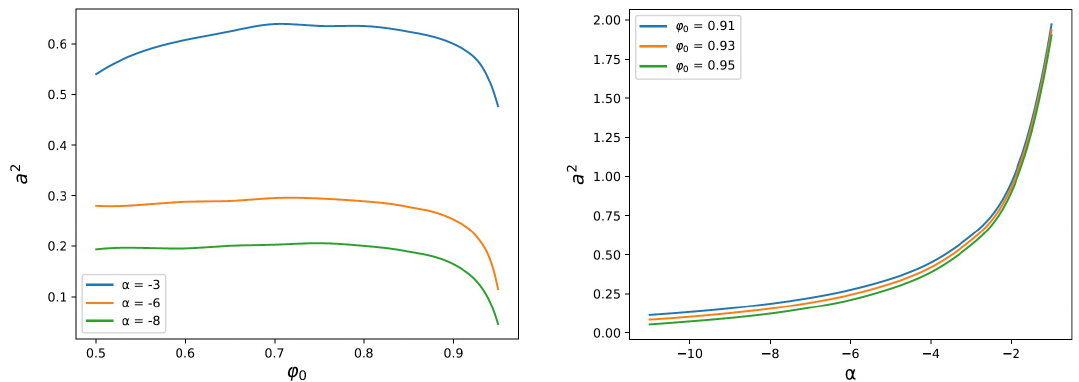
Figure 19 . Left: the squashing parameter a 2 as a function of ϕ 0 for certain values of α , for Bolt end-point solutions. Right: the squashing parameter a 2 as a function of α for fixed values of ϕ Bolt end-point